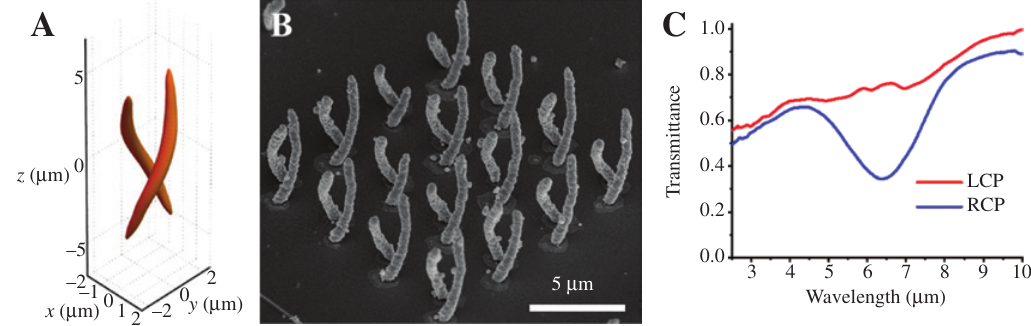
Figure 3: The photoreduction of silver double helix with double-helix beam superposed with LG modes: (1,1), (3,5), (5,9), (7,13), (9,17). (A) The double-helix focal intensity distribution. (B) The SEM images of an array of silver double helix. (C) The measured transmittances of the double-helix silver array for LCP and RCP light at normal